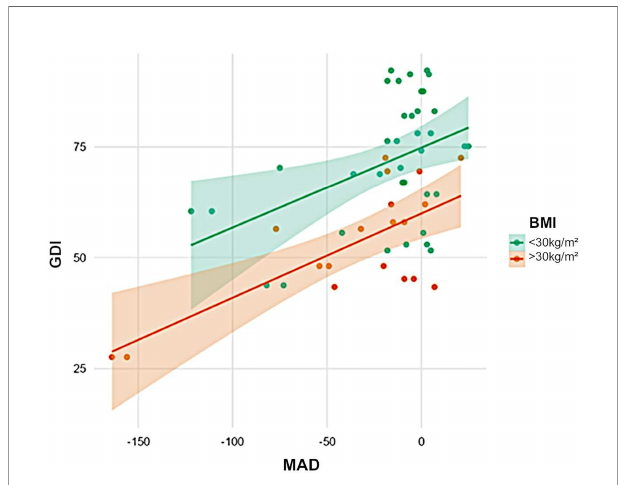
FIGURE 4 | In fl uence of weight and axial deviation on gait scores. Obesity (orange) was associated with low GDI scores (green). Furthermore, varus was negatively correlated with GDI. Obese patients with varus deformity had the lowest scores.